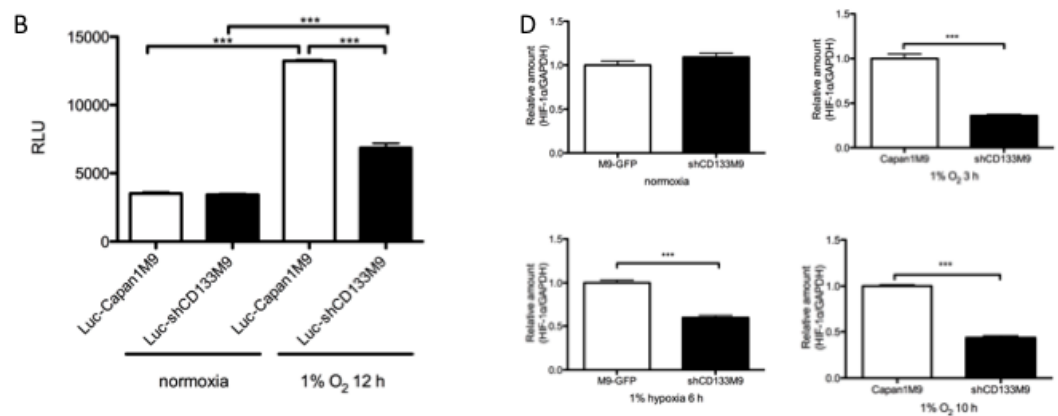
Figure 2. CD133 regulates HIF-1 α under hypoxic condition. ( A ) Western blots confirmed CD133 silencing decreased HIF-1 α protein levels in each period, both under 1% hypoxia and normoxia with CoCl 2 administration; ( B ) In Capan1M9 and shCD133M9 transfected with HIF-1 α reporter plasmid, there are significant difference of HIF-1 α transactivating activity. CD133 silencing also decreased HIF-1 α transactivation activity; ( C ) The ratio of HIF-1 α + cells was counted after 12 h 1% O 2 exposure by HIF-1 α nuclear translocation assay. HIF-1 α + cells of shCD133M9 were smaller than that of Capan1M9. ( D ) RT-PCR confirmed CD133 silencing decreased HIF-1 α mRNA levels in each hypoxic period. Data represent mean ± SD of three experiments; *** p < 0.001; **** p < 0.0001.